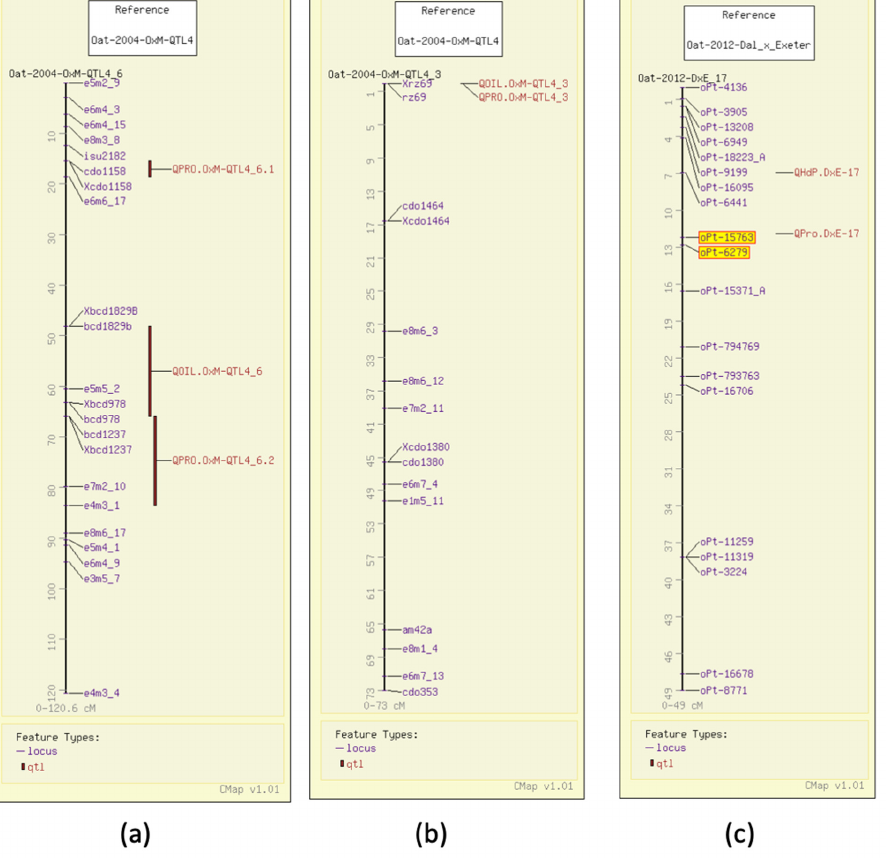
Figure 3. Grain protein QTL illustrated on the CMap map viewing/comparative mapping tool. ( a , b ) QTL for grain protein and groat oil content in the Ogle x Marion population are closely linked on one linkage group and share a common marker on another.; ( c ) DArT markers (highlighted) map the single protein content QTL in Dal x Exeter.